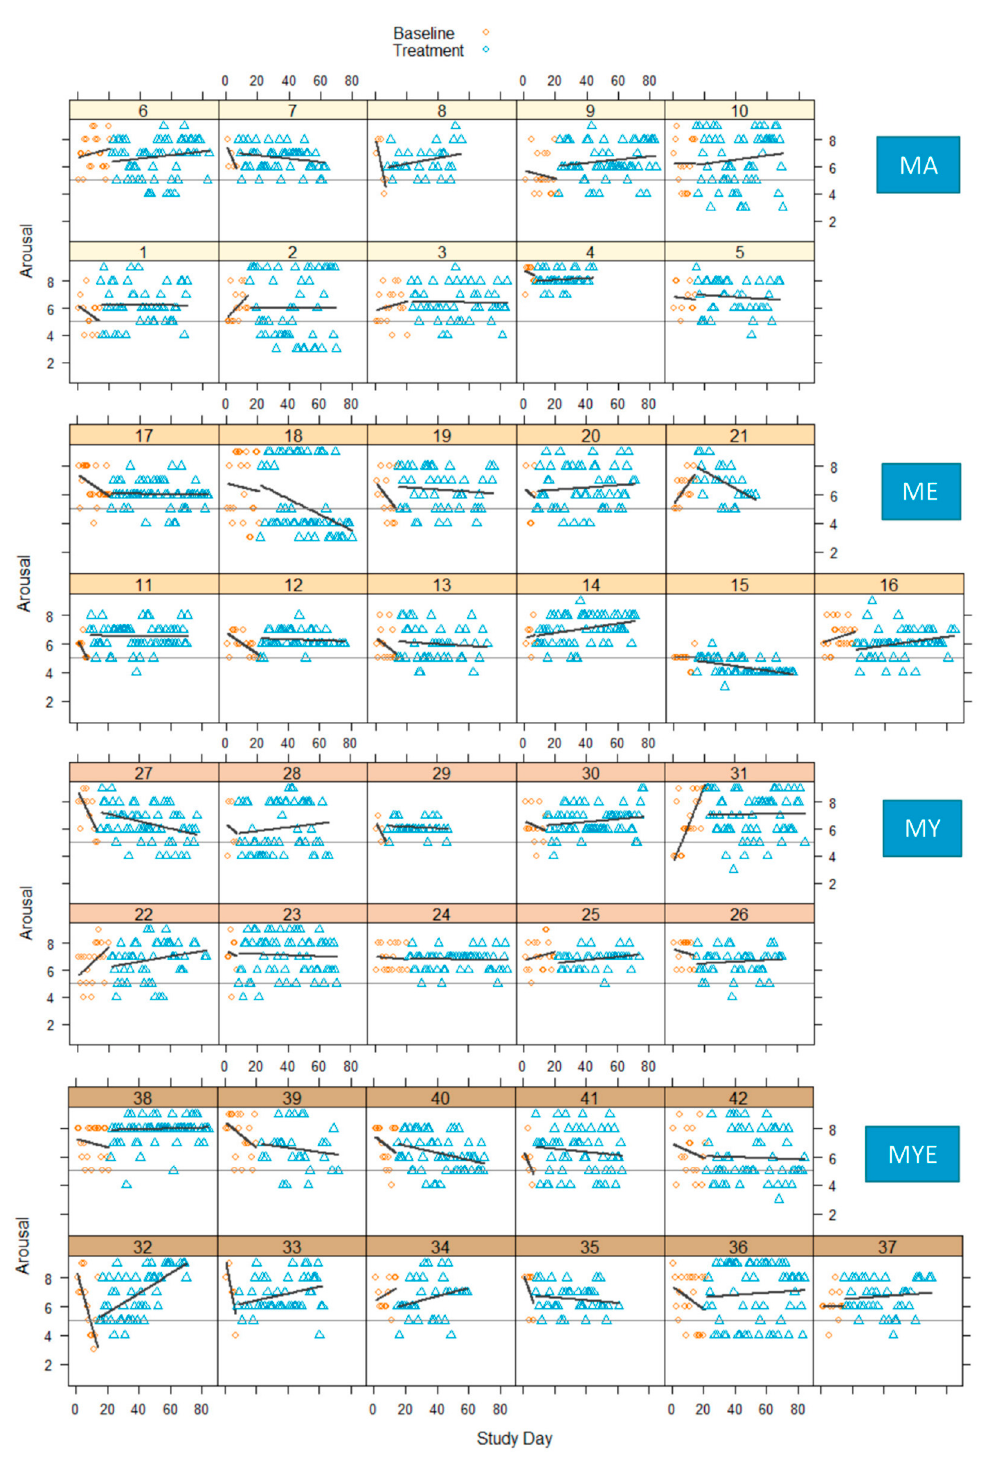
Figure 6. Arousal scores in four conditions during baseline and treatment phases for each partici- pant with regression lines for each phase. Note . Thin horizontal line represents a neutral arousal (value = 5); MA = mantra meditation only; ME = meditation and ethical education; MY = meditation and physical yoga; MYE = meditation, physical yoga, and ethical education.